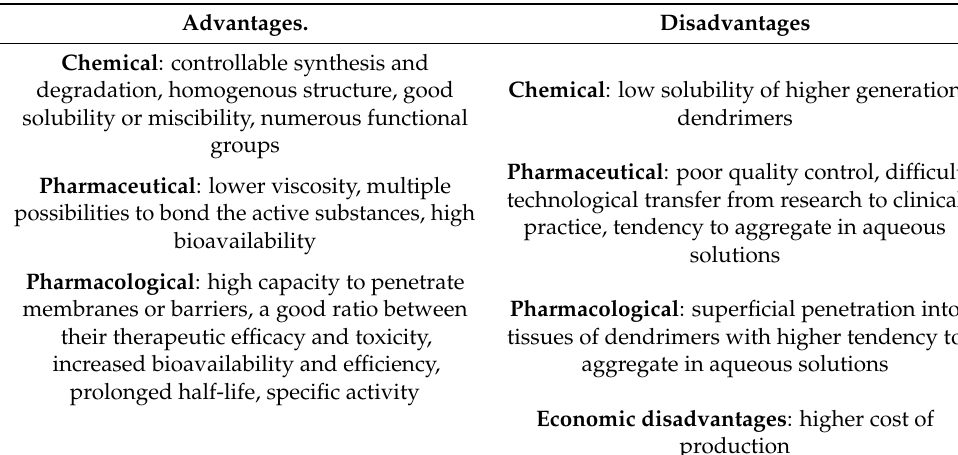
Table 2. The influence of structural modulation on dendrimers ´ properties [140,149–153].